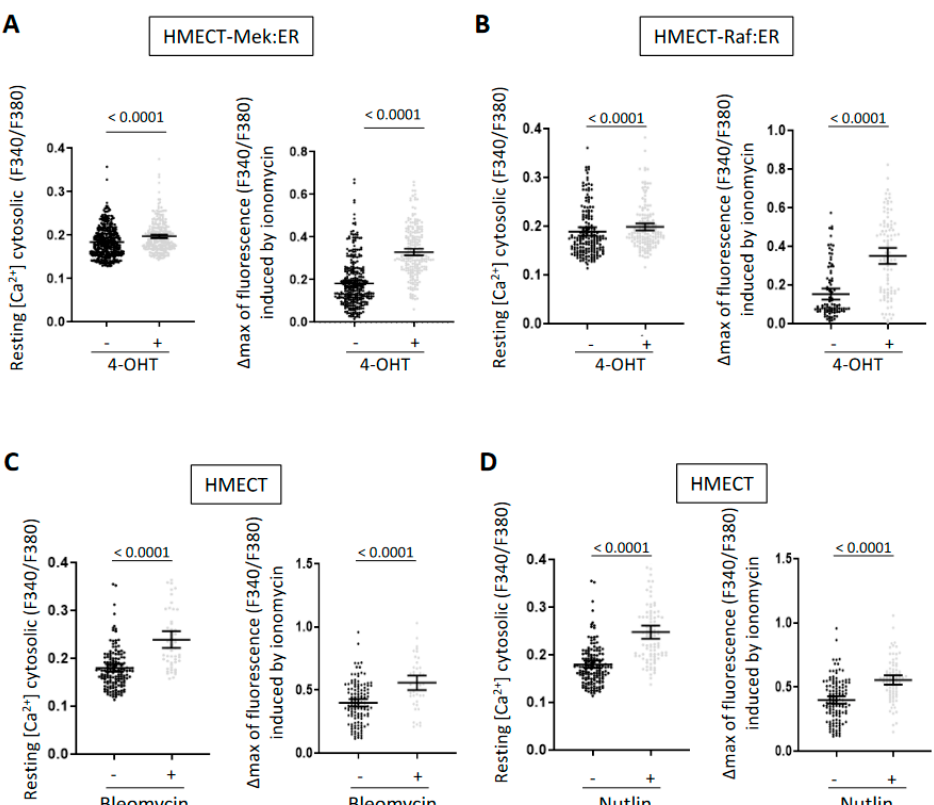
Figure 1. Intracellular Ca 2+ levels are increased in HMECT in response to diverse senescence inducers. Ca 2+ levels were measured with the ratiometric probe Fura2-AM in HMECT either overexpressing 4-OHT-inducible oncogenes Mek:ER ( A ) or Raf:ER ( B ) or treated with bleomycin ( C ) or nutlin ( D ). Resting cytosolic Ca 2+ concentration was evaluated as stable fluorescent ratio before stimulation ( left panels) and the size of Ca 2+ intracellular stocks was estimated as the Ca 2+ peak amplitude obtained after ionomycin stimulation ( right panels). Means +/ − SEM of three independent experiments are presented. Mann–Whitney t -test was performed, and p -values are indicated. Mek:ER cells: Three days after 4-OHT treatment ( − 4-OHT n = 391, +4-OHT n = 271), Raf:ER cells: three days after 4-OHT treatment ( − 4-OHT n = 173, +4-OHT n = 154), bleomycin or nutlin-treated cells: four days after treatment (non-treated n = 231, bleomycin n = 94, nutlin n = 162).